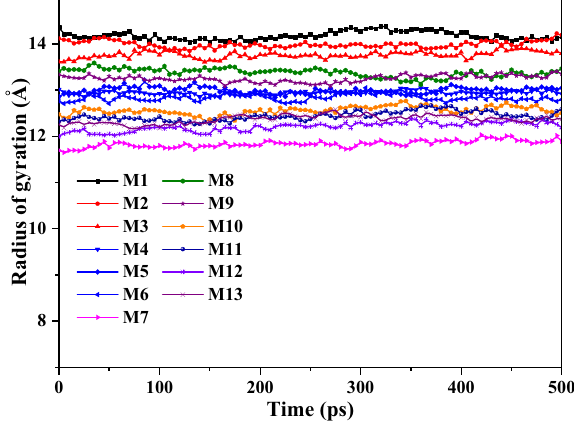
Fig. 8 The radius of gyration of the unaged and aged PDMS models as a function of simulation